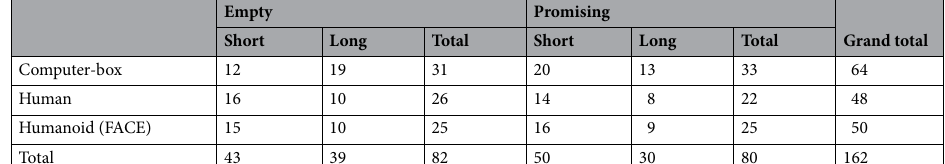
Empty Promising